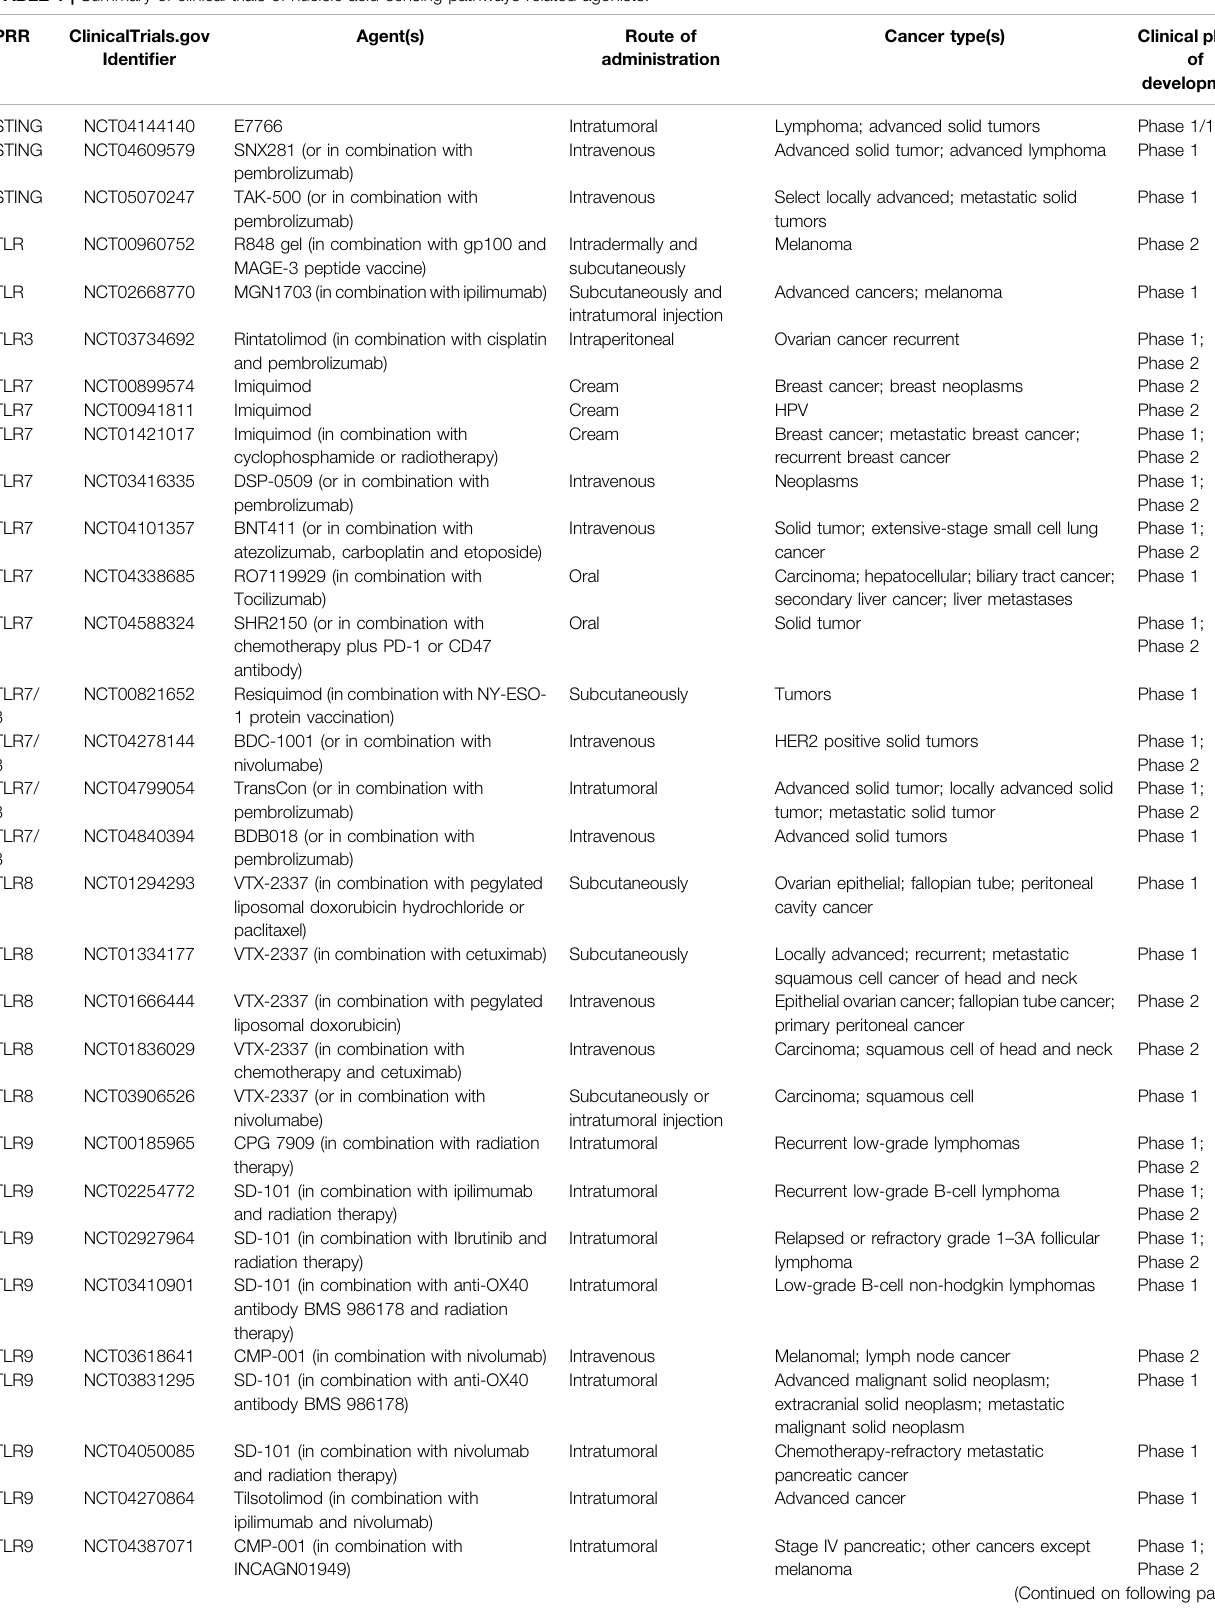
TABLE 1 | Summary of clinical trials of nucleic acid-sensing pathways-related agonists.